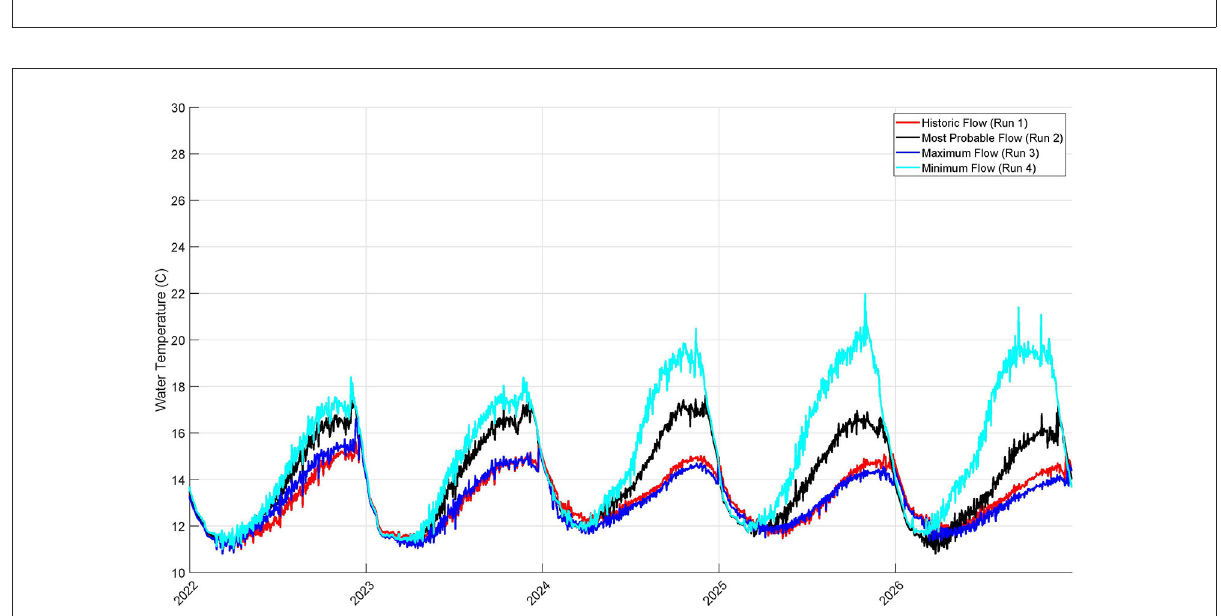
FIGURE7 Projected raw water temperatures at Intake